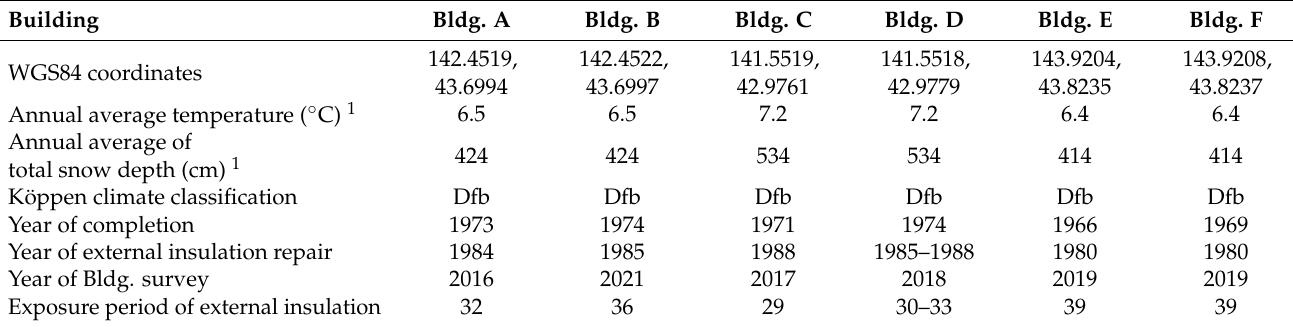
Table 1. Information on the Buildings to be surveyed.